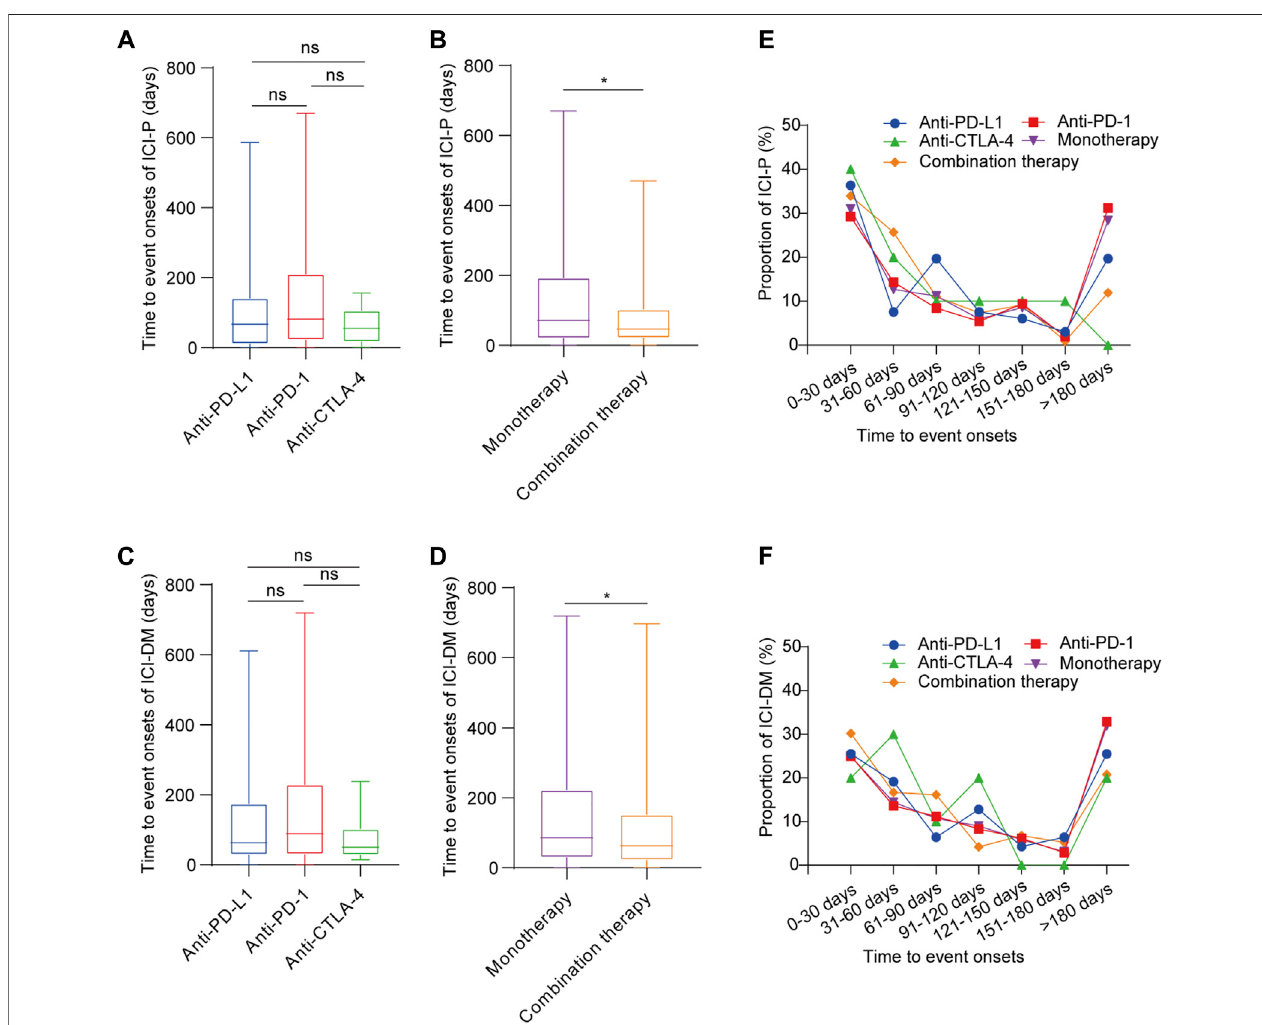
FIGURE 2 | Time to onset of ICI-associated pancreatic AEs following immune checkpoint inhibitor treatments. (A,B) Time to onset of ICI-P following immune checkpoint inhibitor treatments. Kruskal-Wallis test or Mann-Whitney test, * p < 0.05. (C,D) Time to onset of ICI-DM following immune checkpoint inhibitor treatments. Kruskal-Wallis test or Mann-Whitney test, * p < 0.05. (E) The distribution of time to onset of pancreatitis following immune checkpoint inhibitor treatments. (F) The distribution of time to onset of diabetes mellitus following immune checkpoint inhibitor treatments.